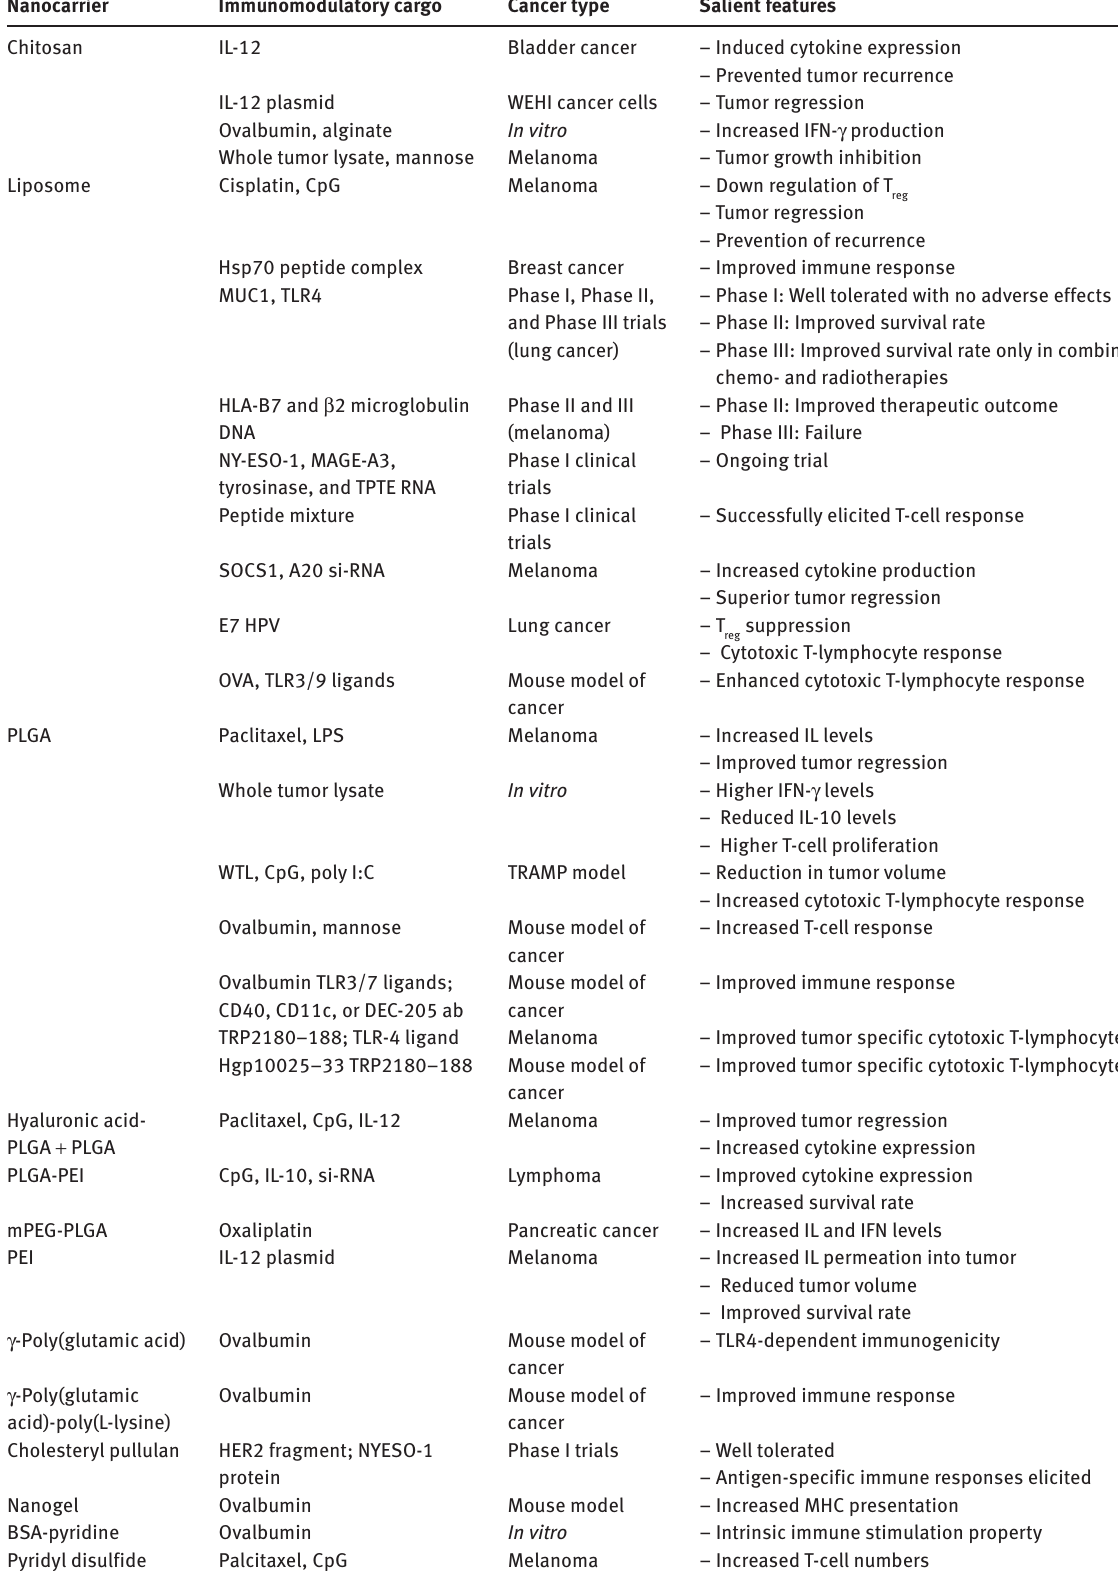
Table 2: Nanocarriers employed for immunotherapy [99].